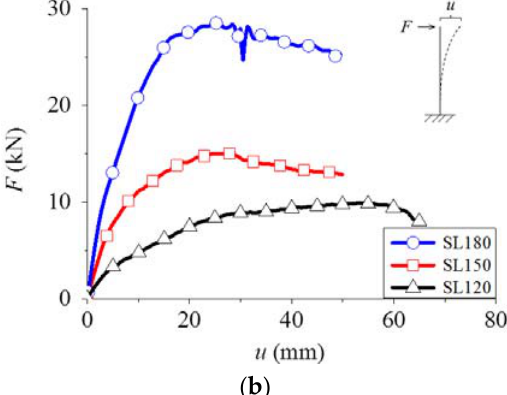
Figure 4. Static test results. ( a ) Flexural failure mode; ( b ) Load ‒ displacement curves. Table 3. Results of static tests.